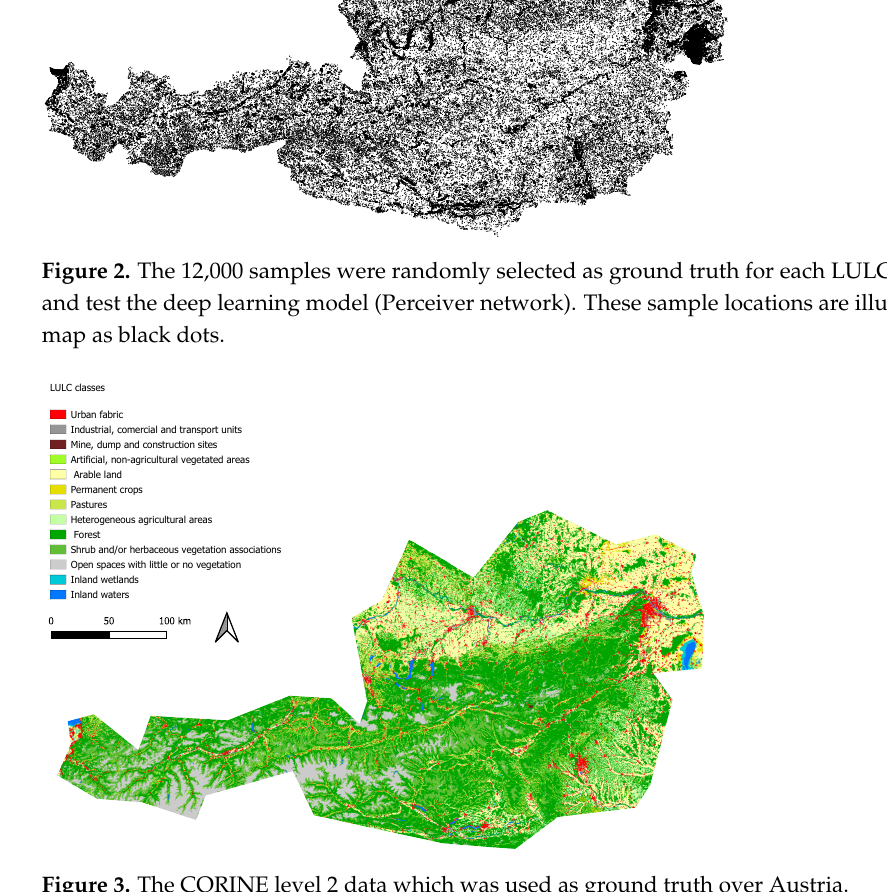
Figure 3. The CORINE level 2 data which was used as ground truth over